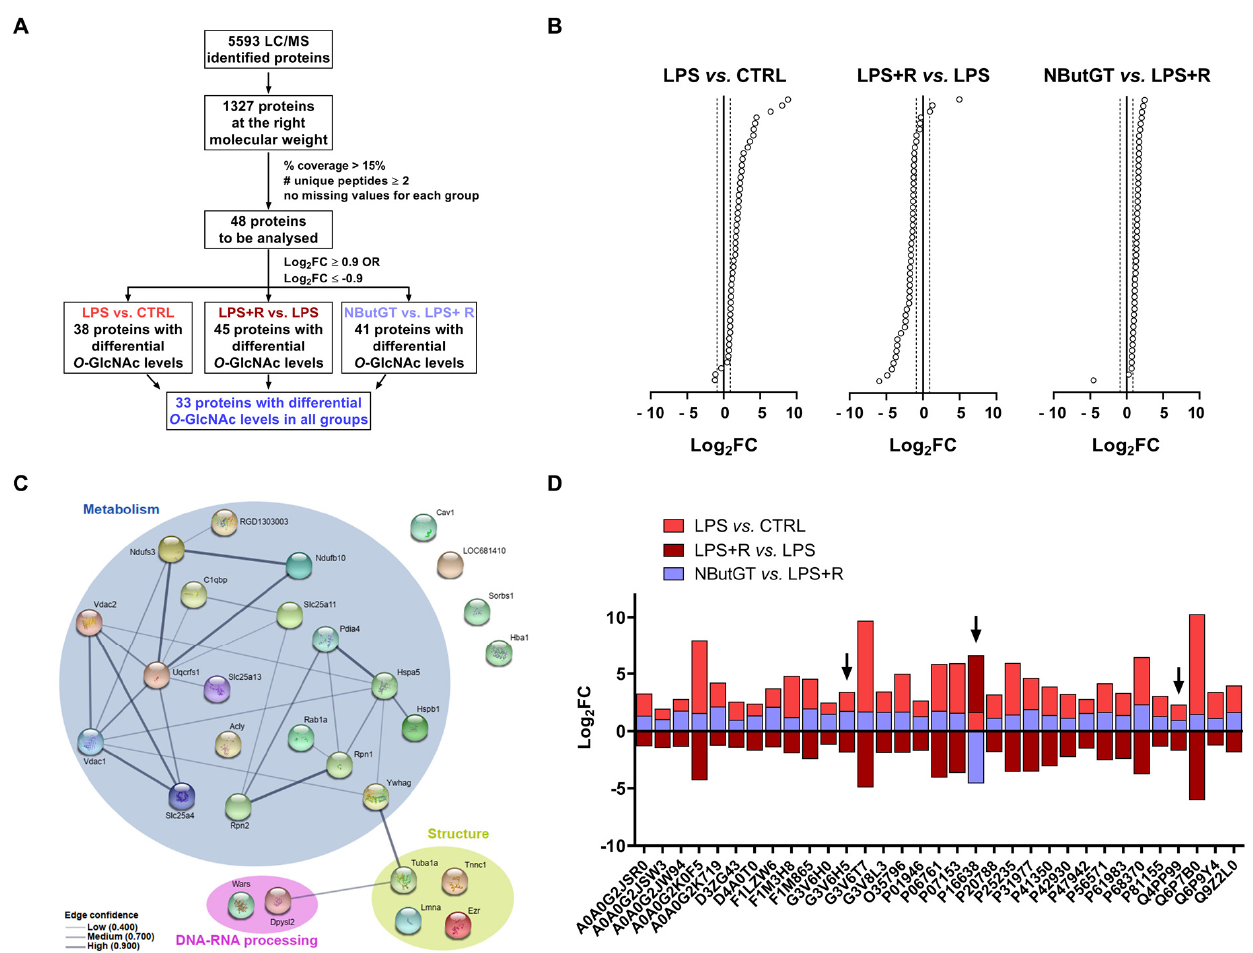
Figure 4. Flow chart and proteins of interest. ( A ) Flowchart of mass spectrometry analysis ( B ) Log 2 (fold change) of O -GlcNAcylation levels of selected proteins. ( C ) Protein-protein network analysis (STRING network) of proteins with a Log 2 (fold change) >0.9 or < − 0.9. ( D ) Log 2 (fold change) of O -GlcNAcylation levels of proteins differentially O -GlcNAcylated in the LPS, LPS+R and NButGT groups. CTRL: control group, LPS: i.v. injection of LPS (20 mg/kg), LPS+R: subcutaneous administration of 10 mL/kg of NaCl 0.9%, NButGT: resuscitation supplemented with NButGT (10 mg/kg). n =